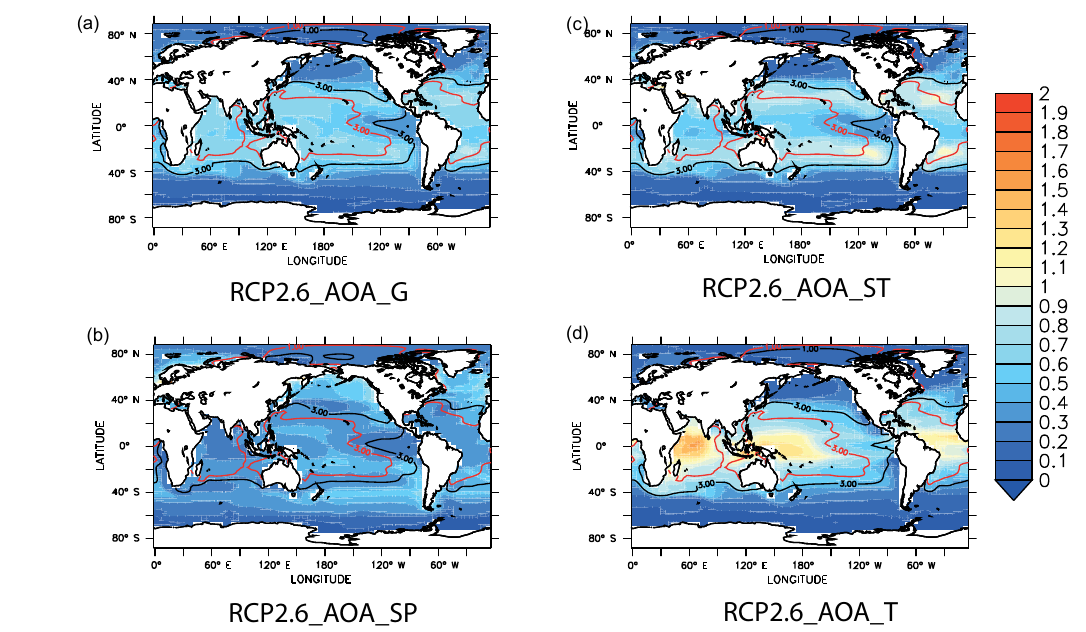
Figure 13. The spatial map of the differences in surface aragonite saturation state in 2090 (mean; 2081–2100), associated with global and regional AOA under RCP2.6, relative to RCP2.6 with no AOA. Contoured on each map are the values of aragonite saturation state of 1 and 3; please see the text for more explanation. The red contours represent RCP2.6 without AOA and the black contours represent RCP2.6 with AOA for each